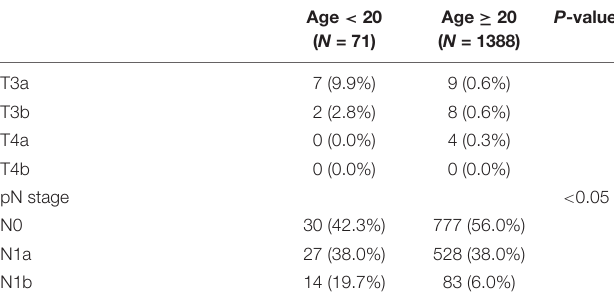
TABLE 2 | Clinico-pathologic characteristics of propensity-matched PTC patients according to age